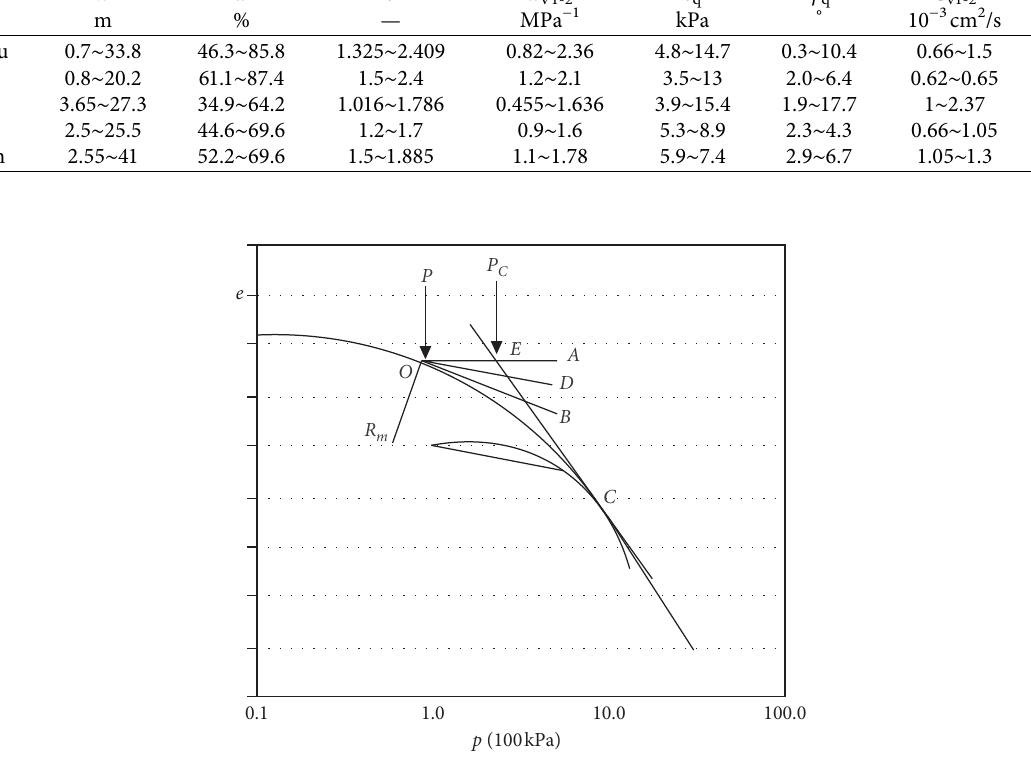
Figure 2: Schematic diagram of calculating P